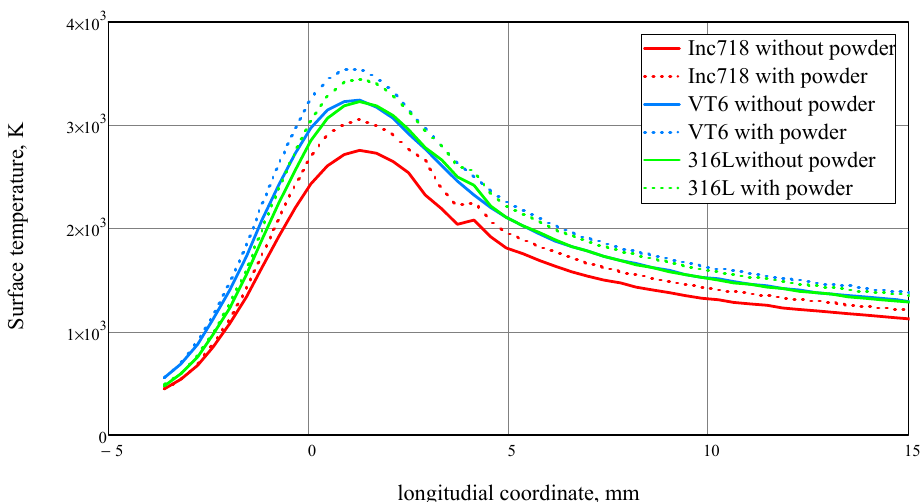
Figure 3. Melt pool top surface profiles for Inconel718, VT6, and 316 L steel in comparison with one